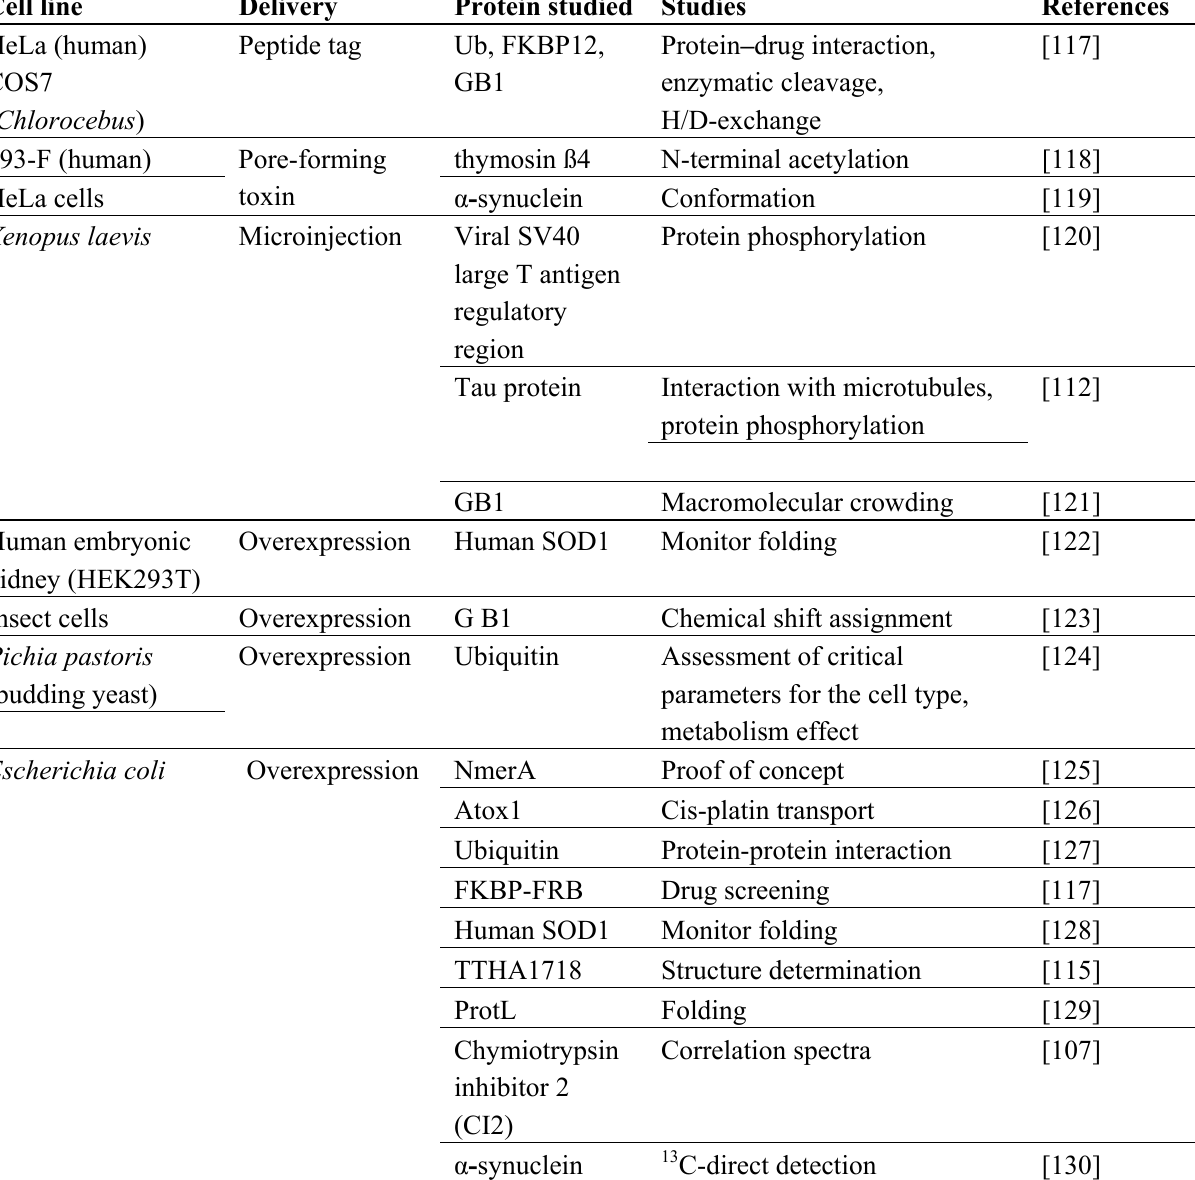
Table 2. Types of cells, delivery methods, proteins, and experiments used in in-cell NMR. MerA: bacterial putative mercuric reductase; GB1: B1 domain of streptococcal protein